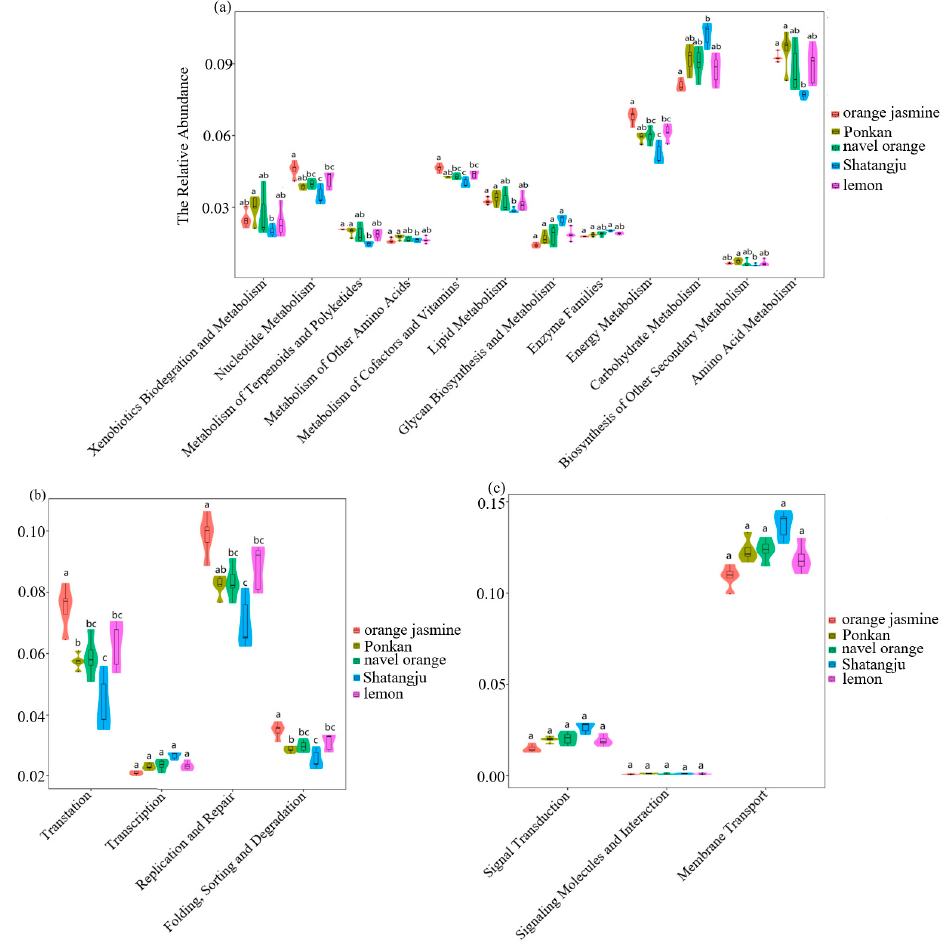
Figure 7. Comparison of predicted KEGG pathways of D. citri gut microbes feeding on different host plants. The inferred metabolic pathways are shown with Metabolism ( a ), Genetic Information Processing ( b ), Envionmental Information Processing ( c ). The bars represent the relative abundance predicted for a psyllid sample. Different letters indicate that the values are significantly different ( p <